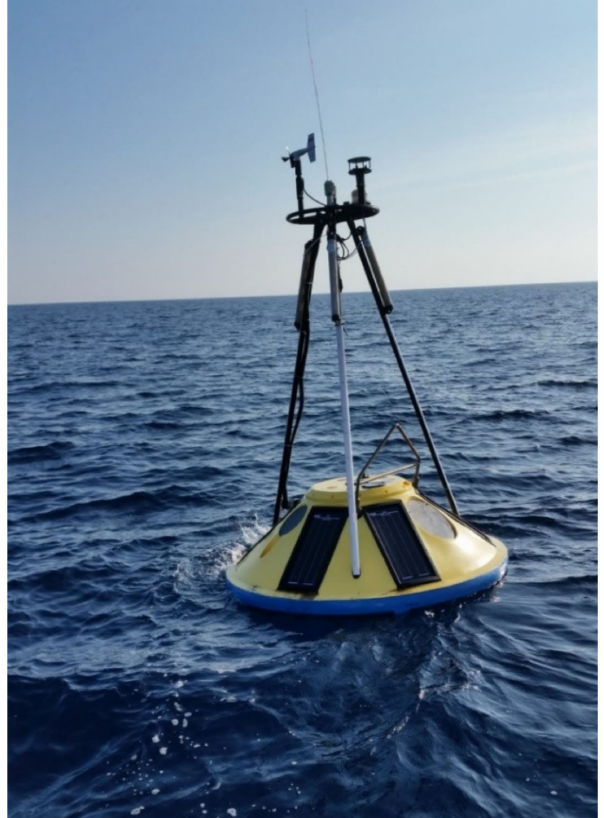
Figure 2. The Capo Mele moored buoy is a Fugro Oceanor SEAWATCH Midi 185 (radius of 1.85 m). It is located at about 3NM from Andora port (Liguria, Italy). Thanks to a weather station 2 m above sea level, the buoy measures wind (direction, intensity, gust), atmospheric pressure, humidity, and air temperature. The observed marine parameters are wave significant height and maximum peak, wave period and direction, current intensity and direction from 3.5 to 70 m, and sea surface temperature. Photo courtesy of Regional Agency for Environmental Protection of Liguria Region